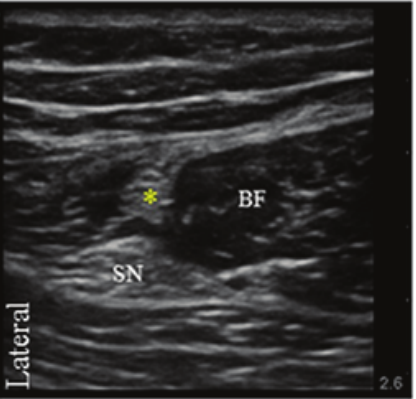
Figure 1: Transverse ultrasound image of the posterior femoral cutaneous nerve (asterisk) located deep to the gluteus maximus muscle and lateral to the biceps femoris muscle (BF). Sciatic nerve (SN).